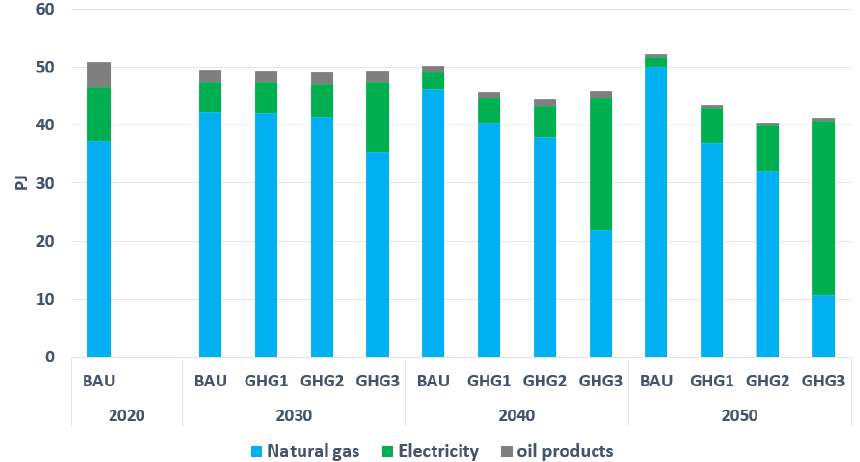
Figure 9. Final energy consumption by type in the commercial